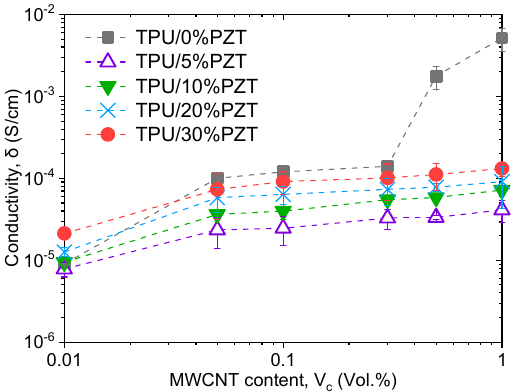
Figure 5. Electrical conductivity of TPU / PZT / MWCNT composites as a function of MWCNT contents at various PZT contents, measured at a frequency of 10 5 Hz.